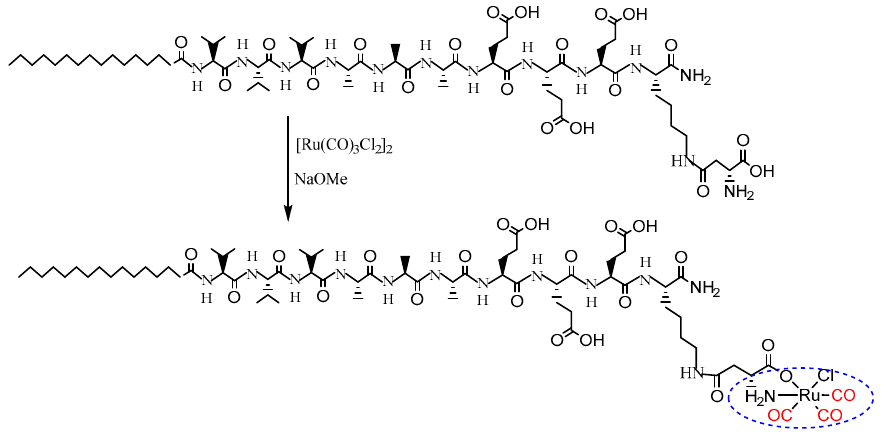
Figure 9. Synthesis of PA2 having CO ‐ moiety for spontaneous release CO.